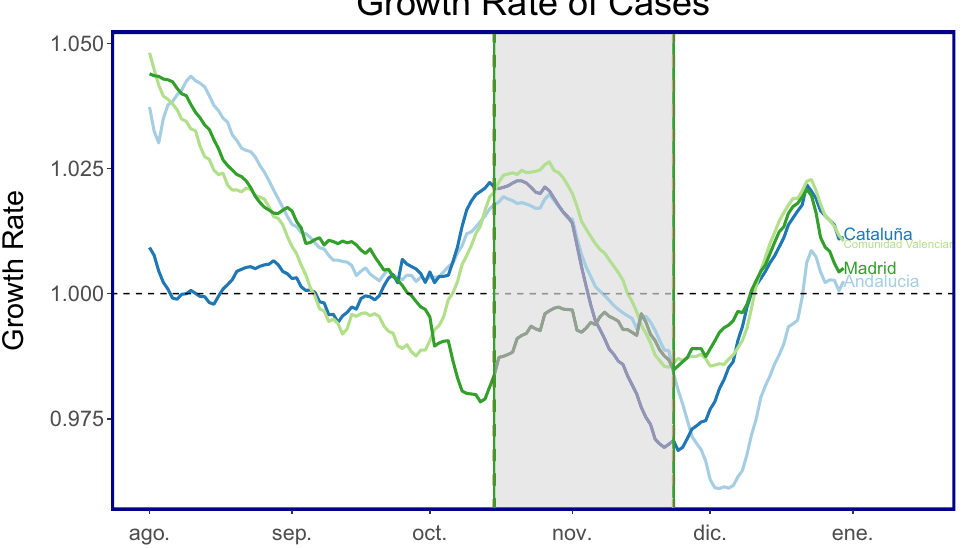
Figure 14. Growth rate (GR) of cases from August until December for four of the most populous regions in Spain. The shaded area corresponds to when the policy of closing bars and restaurants was implemented. On the x-axis, dic refers to Diciembre (December) and ene refers to Enero (January).